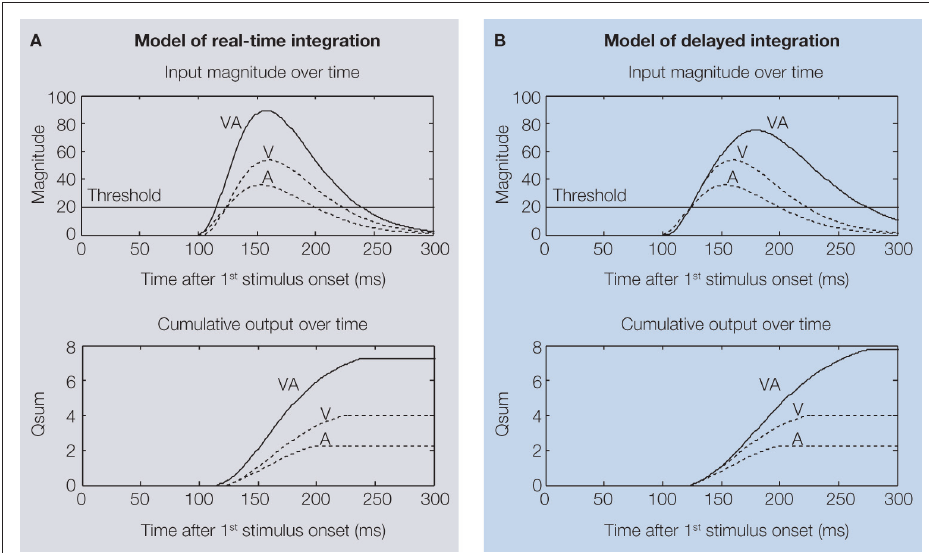
Figure 2 | Two different models for the temporal profile of multisensory integration. Illustrated are putative unisensory visual (V), auditory (A), and multisensory (VA) input magnitudes (top) and cumulative output magnitudes (bottom) as a function of time. If inputs are integrated in real-time (left, A ), the multisensory input magnitude will cross threshold earlier than either unisensory input (upper-left). This will produce a multisensory response with a shorter response latency and higher initial firing rate. The predicted cumulative response profile (qsum) is illustrated in the lower-left corner. Alternatively, if multisensory integration takes place only later in the response (“delayed integration”, B ), the multisensory and unisensory input profiles will initially appear similar, but the multisensory response will reach a higher peak (upper-right). This will yield multisensory responses that are enhanced in magnitude, but have identical physiological response latencies as the unisensory responses